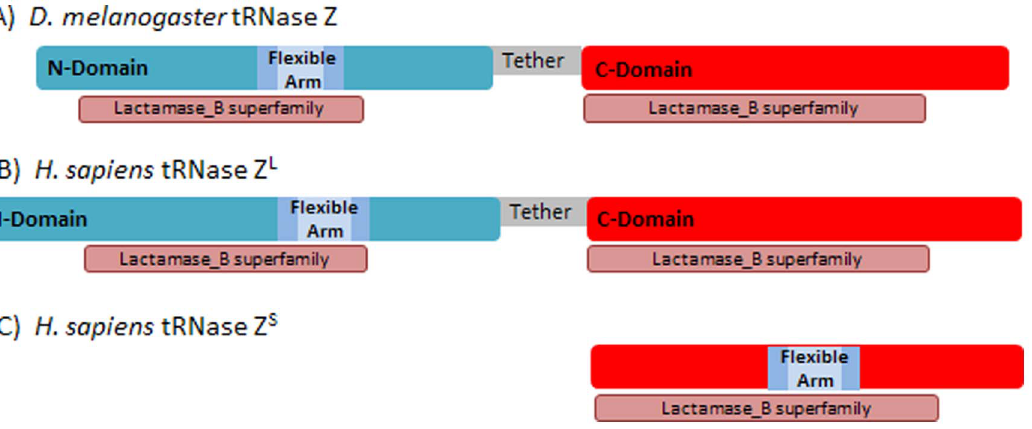
Figure 1. Evolution of tRNase Z L from tRNase Z S by tandem duplication/adaptation. A) D. melanogaster tRNase Z; B) H. sapiens tRNase Z L ; C) H. sapiens tRNase Z S adapted from Domain Search entries in NCBI. Pink regions below amino and carboxy domains, with annotated homology to b -Lactamase superfamily, are consistent with the evolution of tRNase Z L from tRNase Z S by tandem duplication/adaptation. D. melanogaster tRNase Z is accession # NP_724916, taken from discovery of a juvenile hormone inducible cDNA (JHI-1 [43]) that was later found to be D. melanogaster tRNase Z [15,16]. The entry used for H. sapiens tRNase Z L is accession # NP_060597, which was reported to be a candidate human prostate cancer susceptibility gene (ElaC2 22 ) and later shown to be human tRNase Z L [15,44]. H. sapiens tRNase Z S is accession # NP_061166 (ElaC1 [22]). Pink rectangles below sequence tracks indicate the position and boundaries of the blocks that display the greatest sequence similarity to a proto-metallo- b -lactamase unit. The carboxy domain displays greater homology to the archetypal b -Lactamase superfamily than the amino domain. Additional annotations: the flexible arm (FA) is found only in the amino domain (N-Domain) of tRNase Z L and N-Domain and C-Domain are linked by a flexible